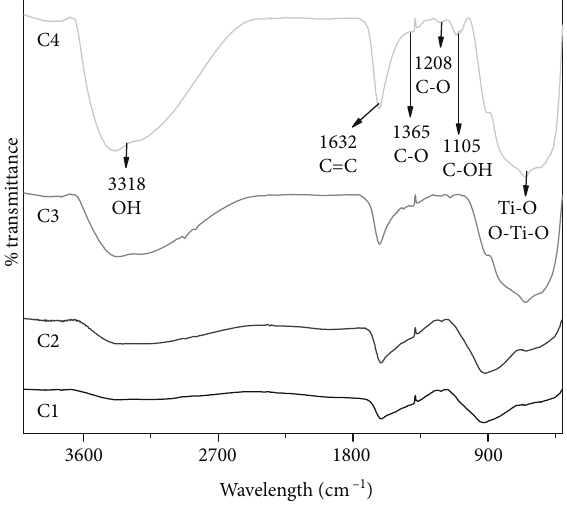
Figure 6: IR spectra of the four compounds for the presence of functional group characteristics of GO.